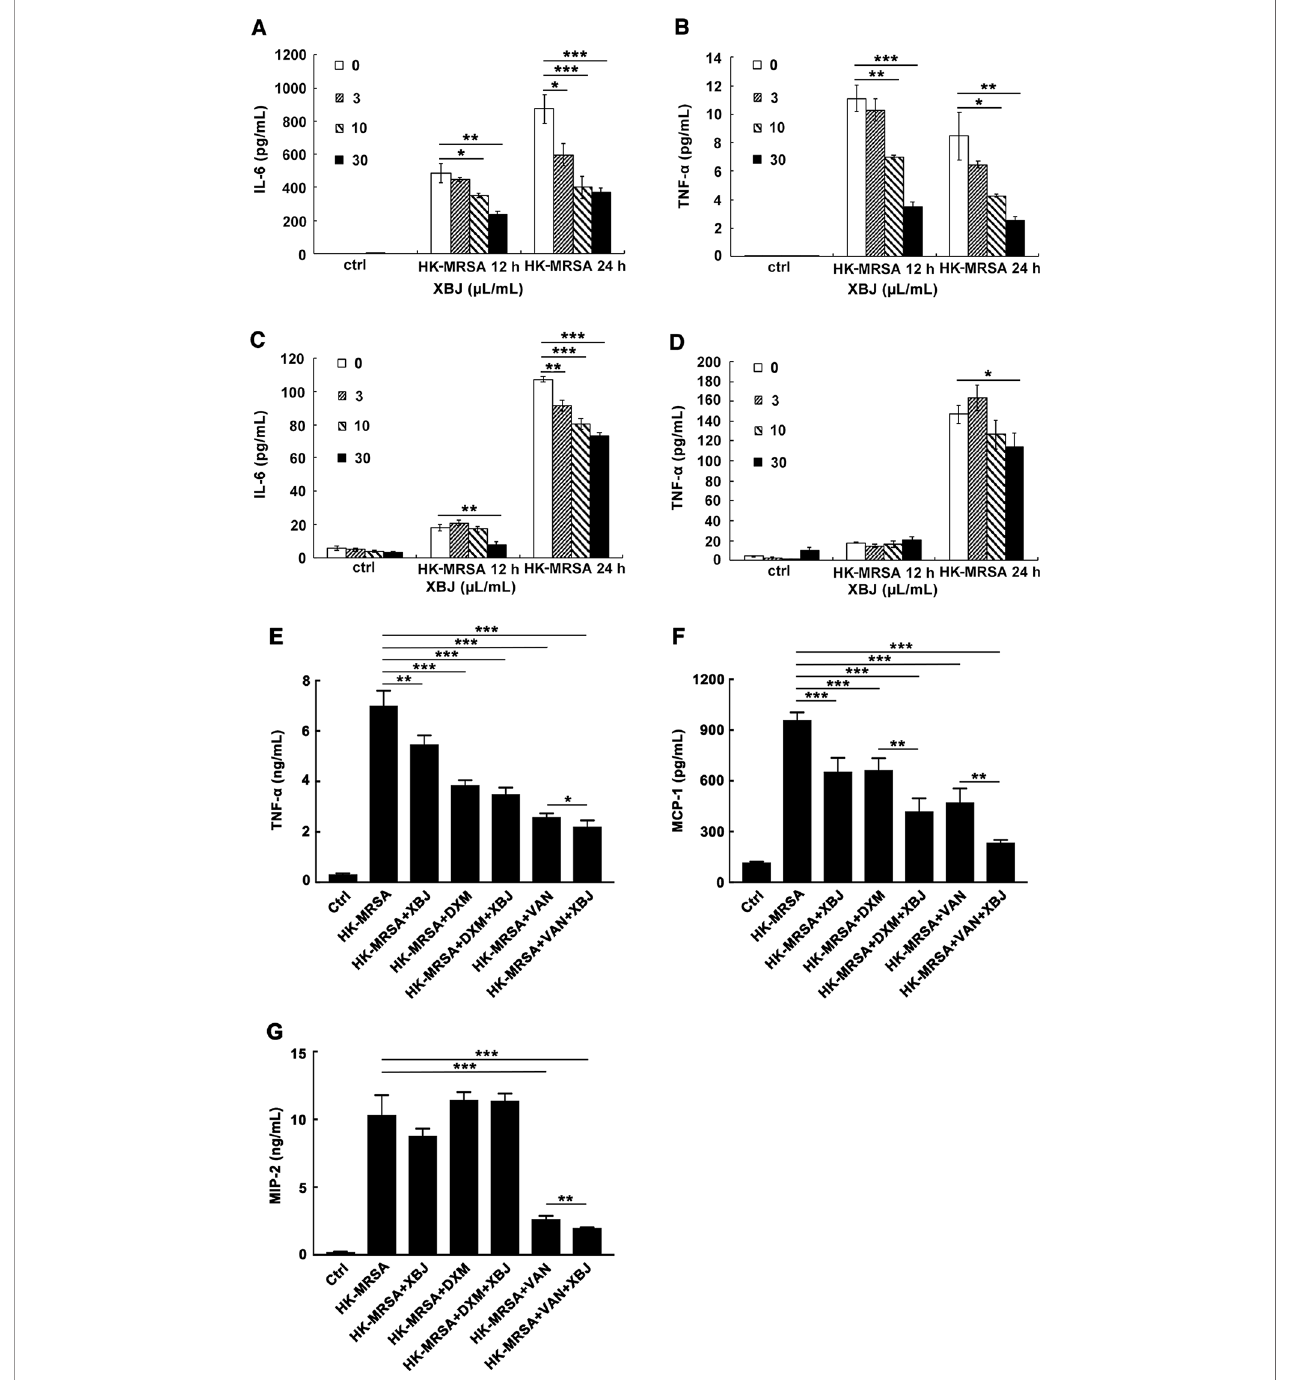
FIGURE 5 | XBJ reduced the secretion of IL-6 and TNF- a and exhibited combined effects with VAN or DXM in HK-MRSA-stimulated macrophages. (A – D) . Mouse primary peritoneal macrophages (3.5 × 10 5 cells/well) or iBMDMs (2 × 10 5 cells/well) were seeded in 24-well plates and incubated overnight. Cells were stimulated by HK-MRSA (MOI=10) and treated with different concentrations of XBJ for 12 or 24 hours. The secretion of cytokines in the cell culture supernatants were determined by ELISA. The expression of IL-6 and TNF- a were detected in primary peritoneal macrophages (A , B) or in iBMDMs (C , D) . Data were shown as mean ± SD (n=3). (E – G) XBJ+DXM or XBJ+VAN decreased the production of HK-MRSA-induced in fl ammatory mediators in Raw264.7. Raw264.7 (2 × 10 5 cells/well) were seeded in 24-well plates and incubated overnight. Cells were stimulated by HK-MRSA (MOI=10) and treated with XBJ (10 µl/ml), DXM (7 µM), VAN (15 µM), and their combination for 24 hours. The secretion of TNF- a (E) , MCP-1 (F) , and MIP-2 (G) in the supernatants were determined by ELISA. Data were shown as mean ± SD (n=4). * , ** , ***Signi fi cantly different at p < 0.05, p < 0.01, and p < 0.001,